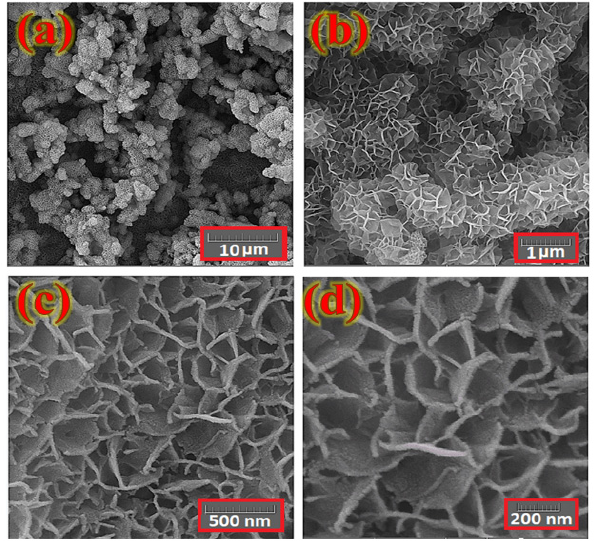
Figure 3. FE-SEM images of a typical Co x NiV y O z layer coated on a Ni foam substrate at various magnifications. ( a ) 10 μm , ( b ) 1 μm , ( c ) 500 nm, ( d ) 200 nm.